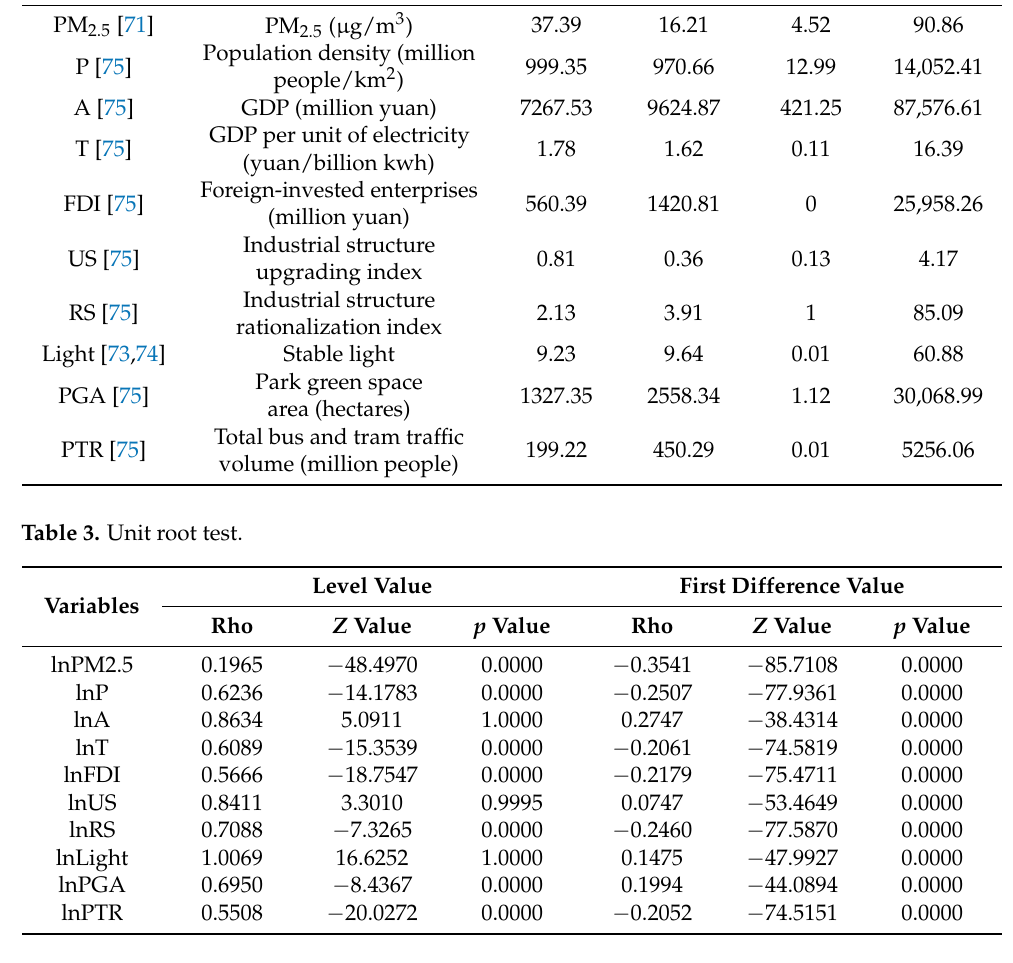
Table 4. Cointegration